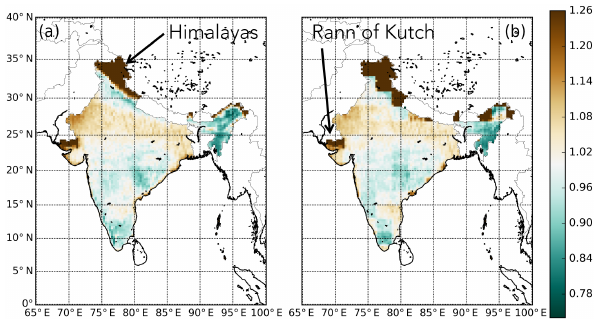
Figure 4. Annual mean air mass factors (AMFs) for 2014 calcu- lated using (a) nested 0 . 25 ◦ × 0 . 3125 ◦ and (b) standard 2 . 0 ◦ × 2 . 5 ◦ GEOS-Chem